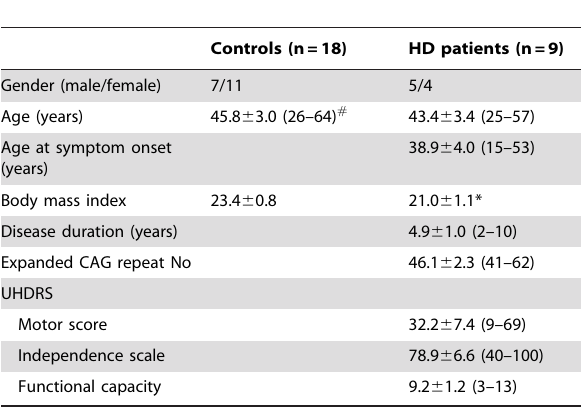
Table 1. Clinical characteristics of the Huntington’s disease (HD) patients and the